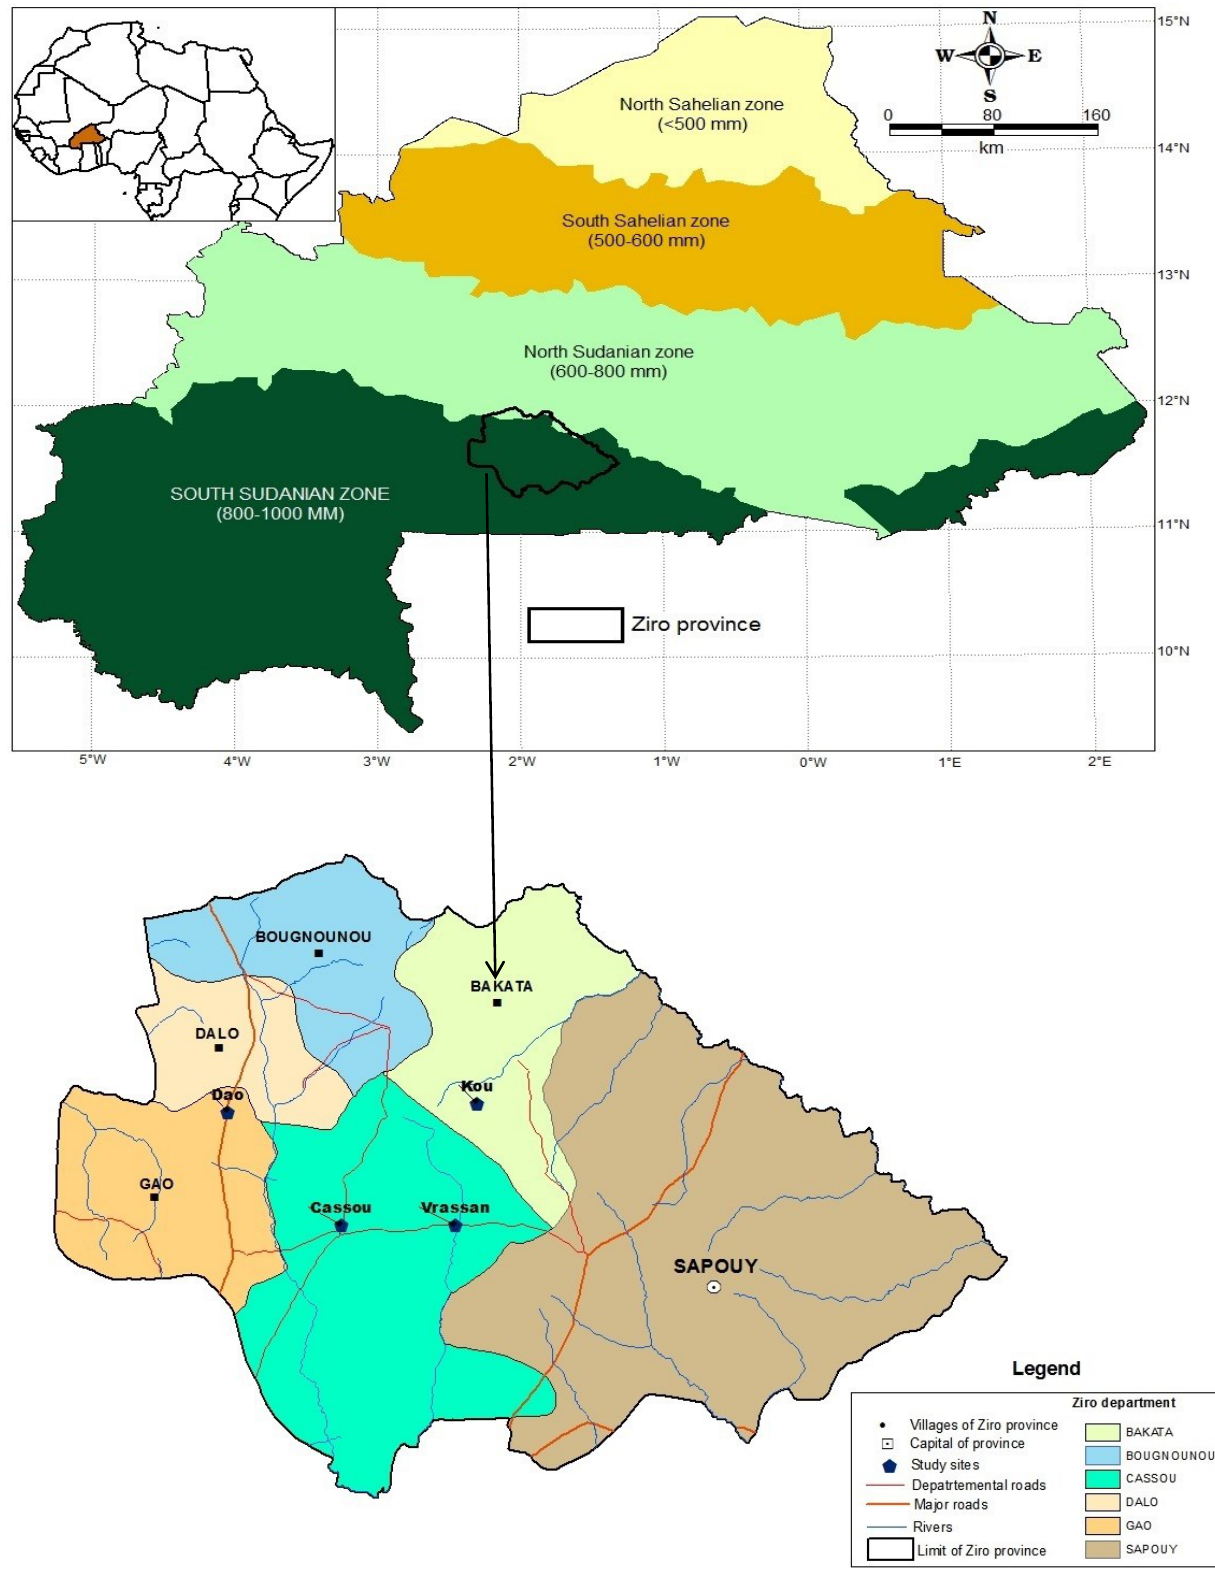
Figure 1. Location of the study villages in the Ziro province, Southern Burkina Faso. The population density was estimated at 28 persons/km 2 in 2007 [31]. The area is composed of three ethnic groups: Gourounsi, Mossi and Fulani with the first group being indigenous while the last